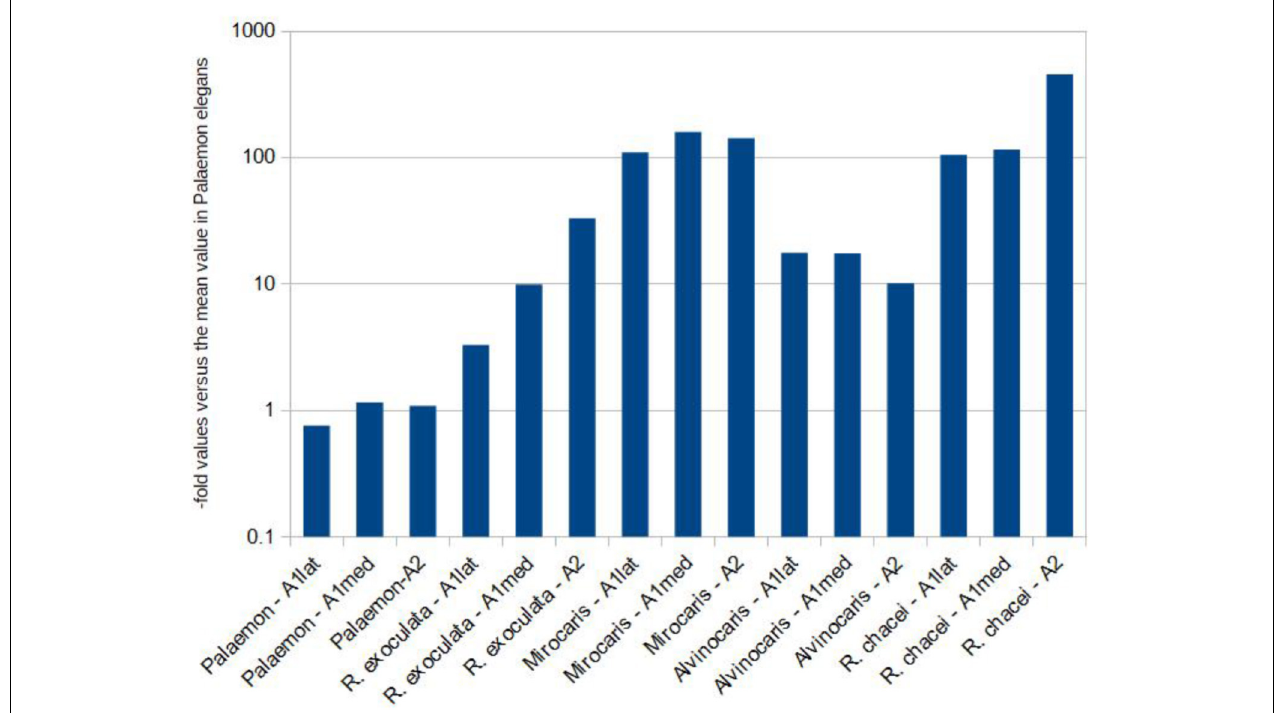
FIGURE 4 | Results from the qPCR-based comparison among samples. The bacterial 16S rRNA gene was the target, and host GAPDH was used as a reference gene. Results are expressed as “-folds” versus the average value obtained from the coastal species Palaemon elegans in order to compare the results among samples. Notice the logarithmic y -axis.